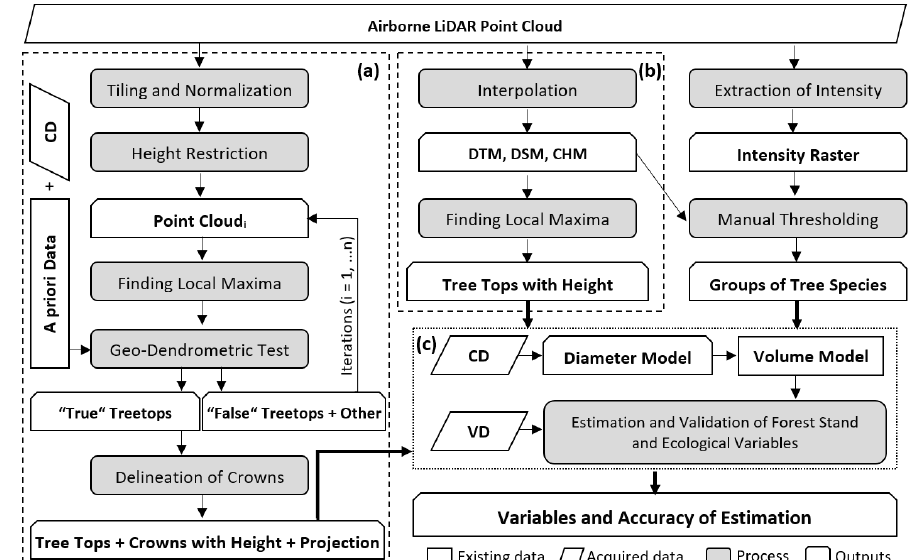
Figure 2. Flowchart of ( a ) multisource-based method and ( b ) raster-based method within the ( c ) estimation of forest stand and ecological variables. Note: CD: Calibration data; VD: Validation data; DTM, DSM: Digital terrain and surface model; CHM: Canopy height model.